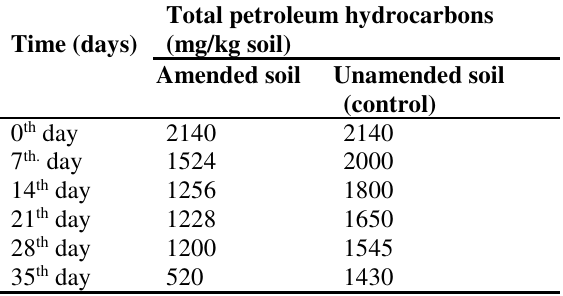
Bioremediation of a soil contaminated with diesel during 35 days